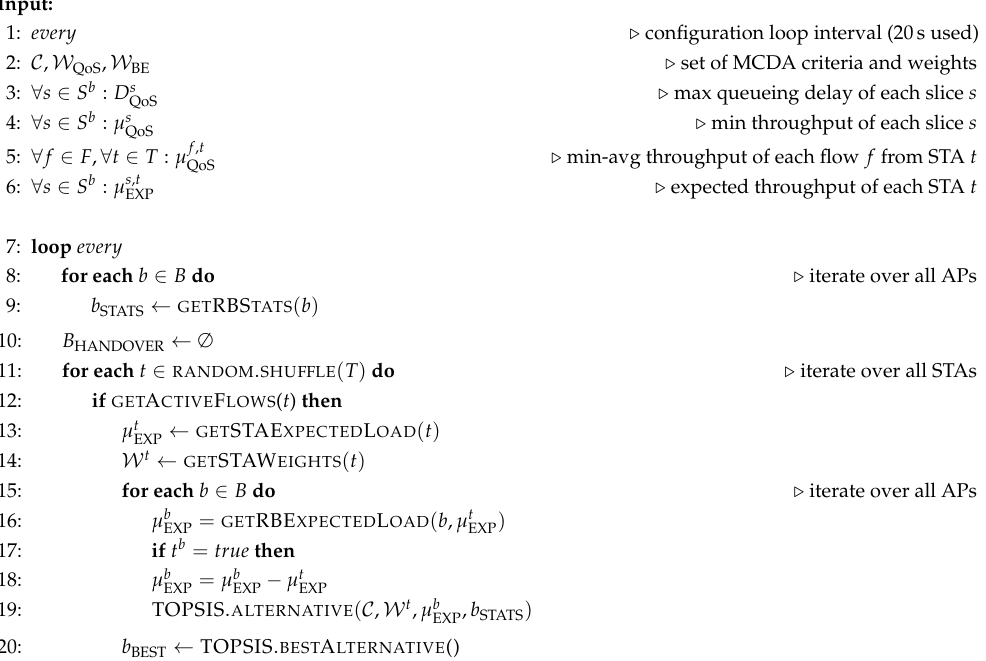
Algorithm 1 User Association